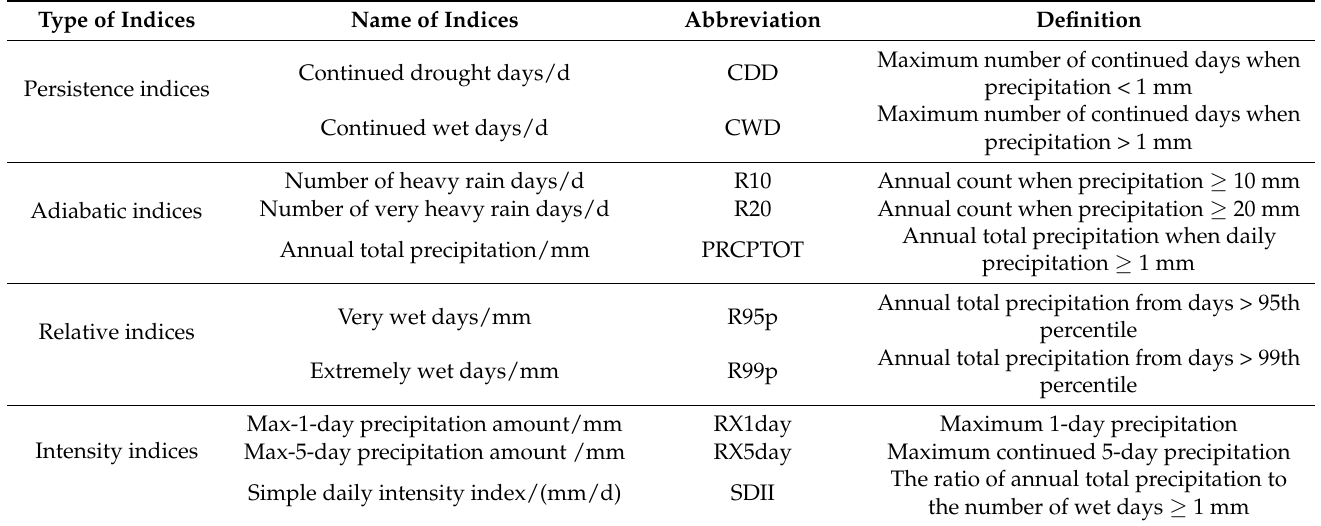
Table 2. Definition of each extreme precipitation